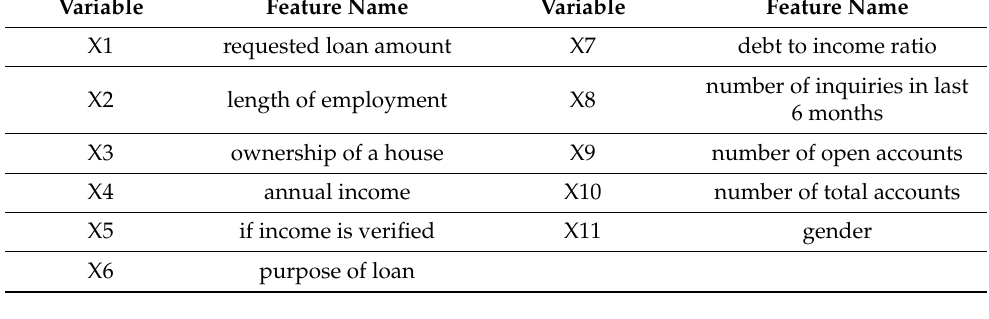
Table 4. Variables on x-axis and their corresponding feature names for dataset 3.